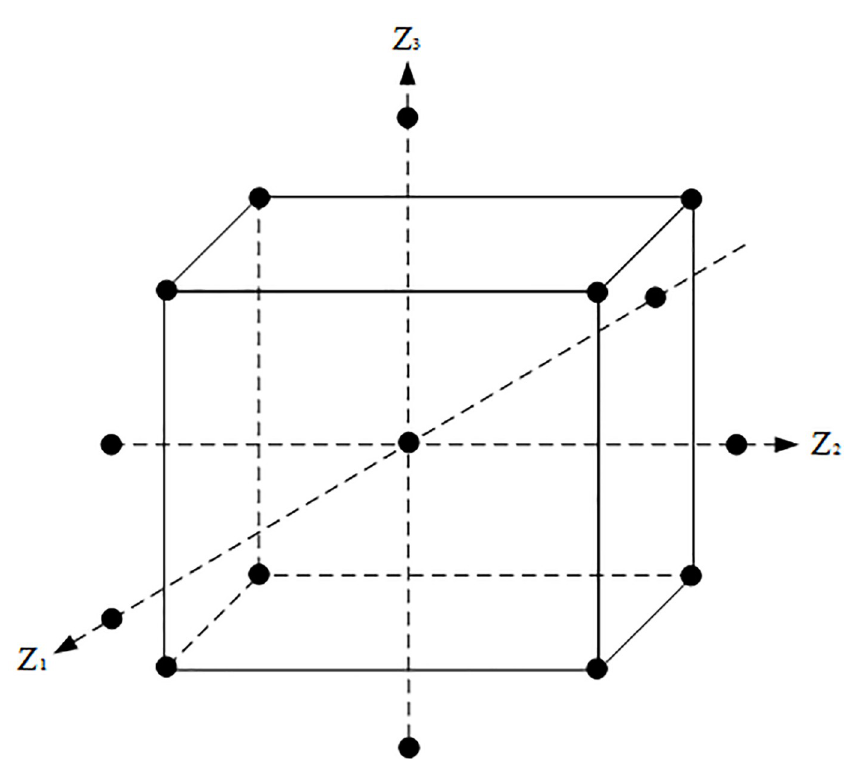
Fig 8. CCD test design